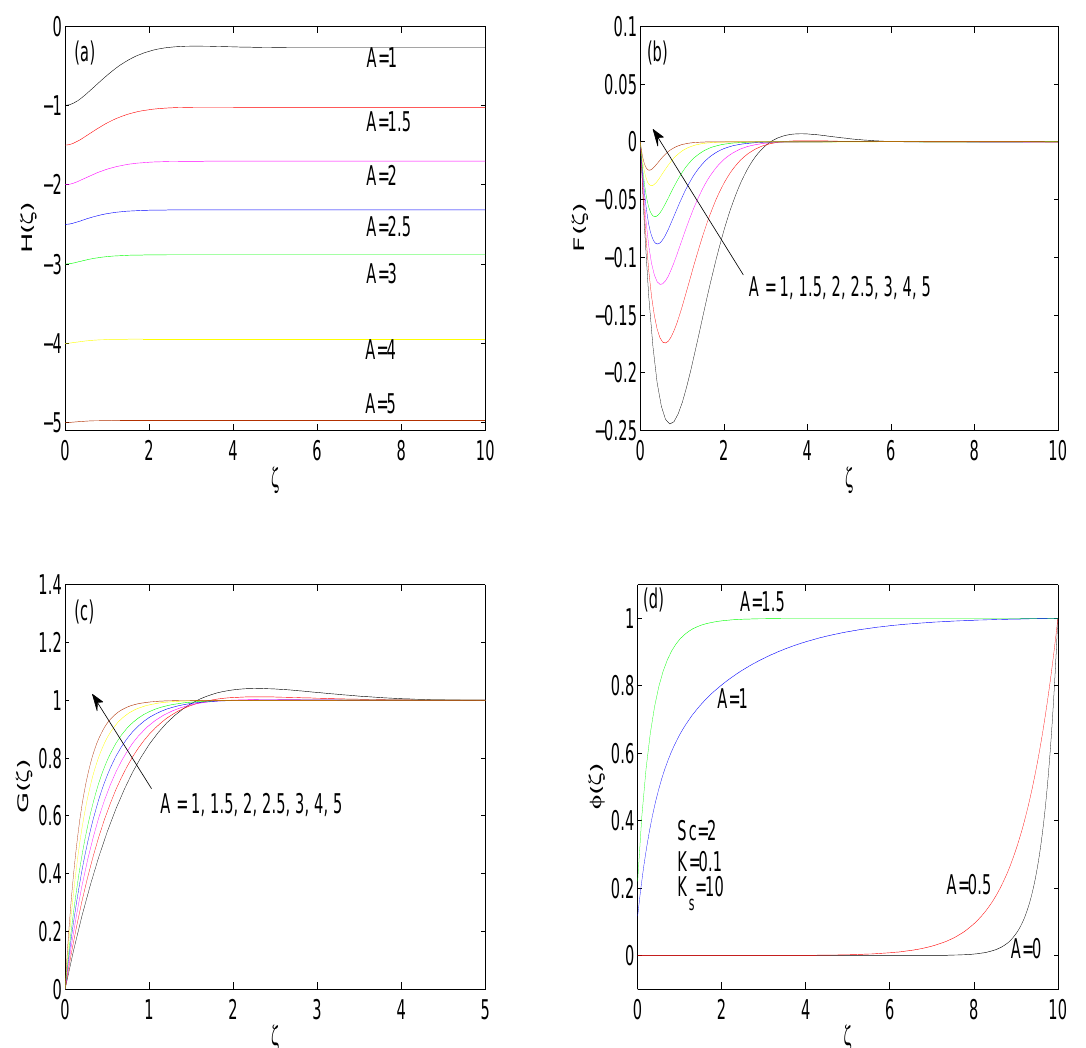
Figure 2. Velocity components ( 𝐻, 𝐹, and 𝐺 ) and 𝜙 for different values of 𝐴 .